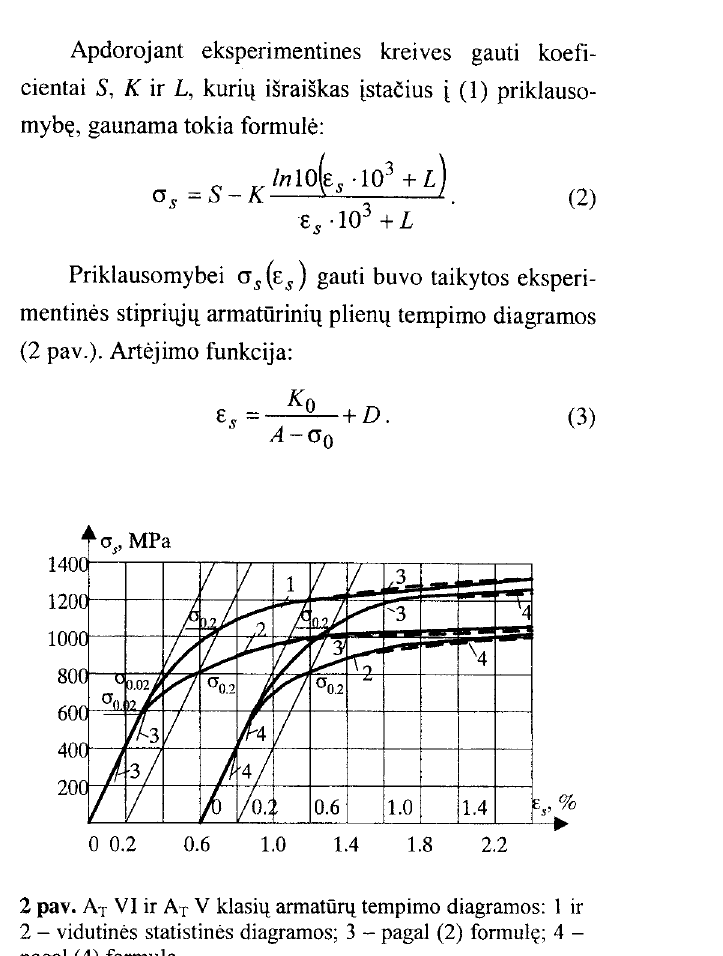
Fig 2. Stress-strain curves for the reinforcement AT VI and Ar V class: 1 and 2 - average statistic curve; 3 - according